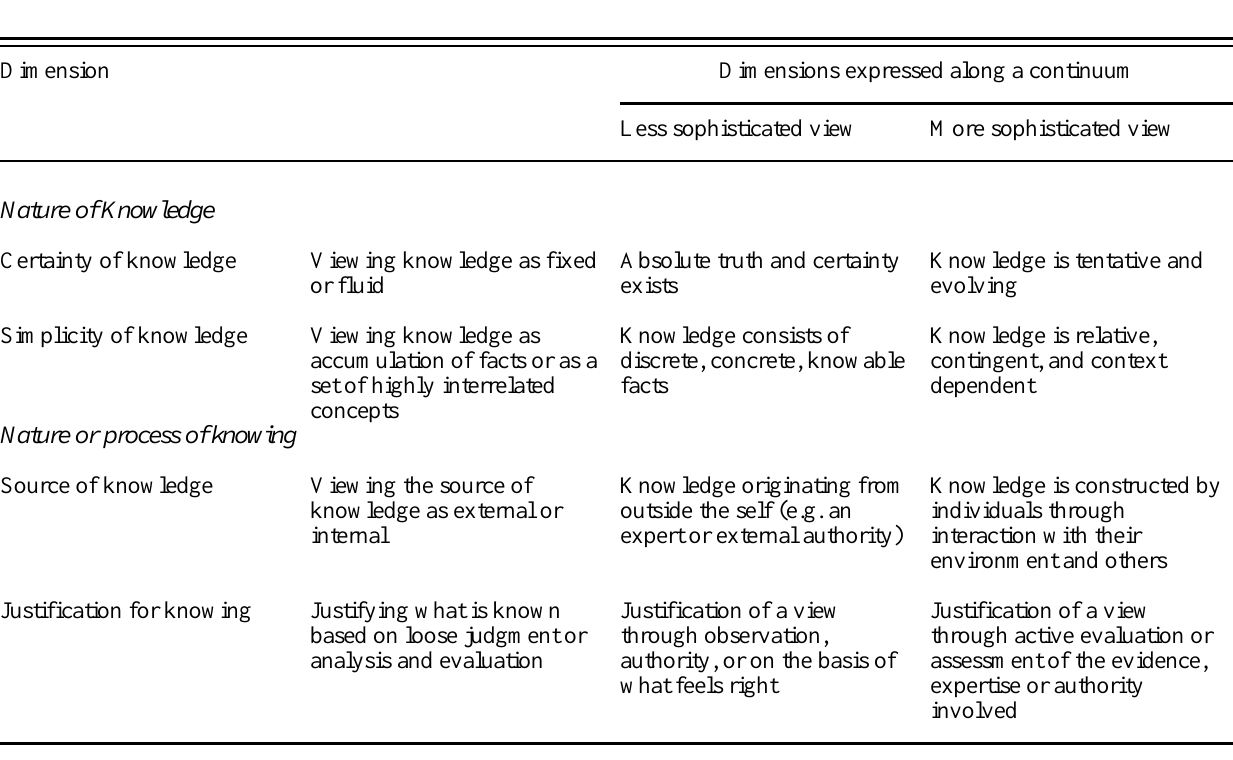
Table 2 . Dimensions of epistemological beliefs (Hofer 2000,